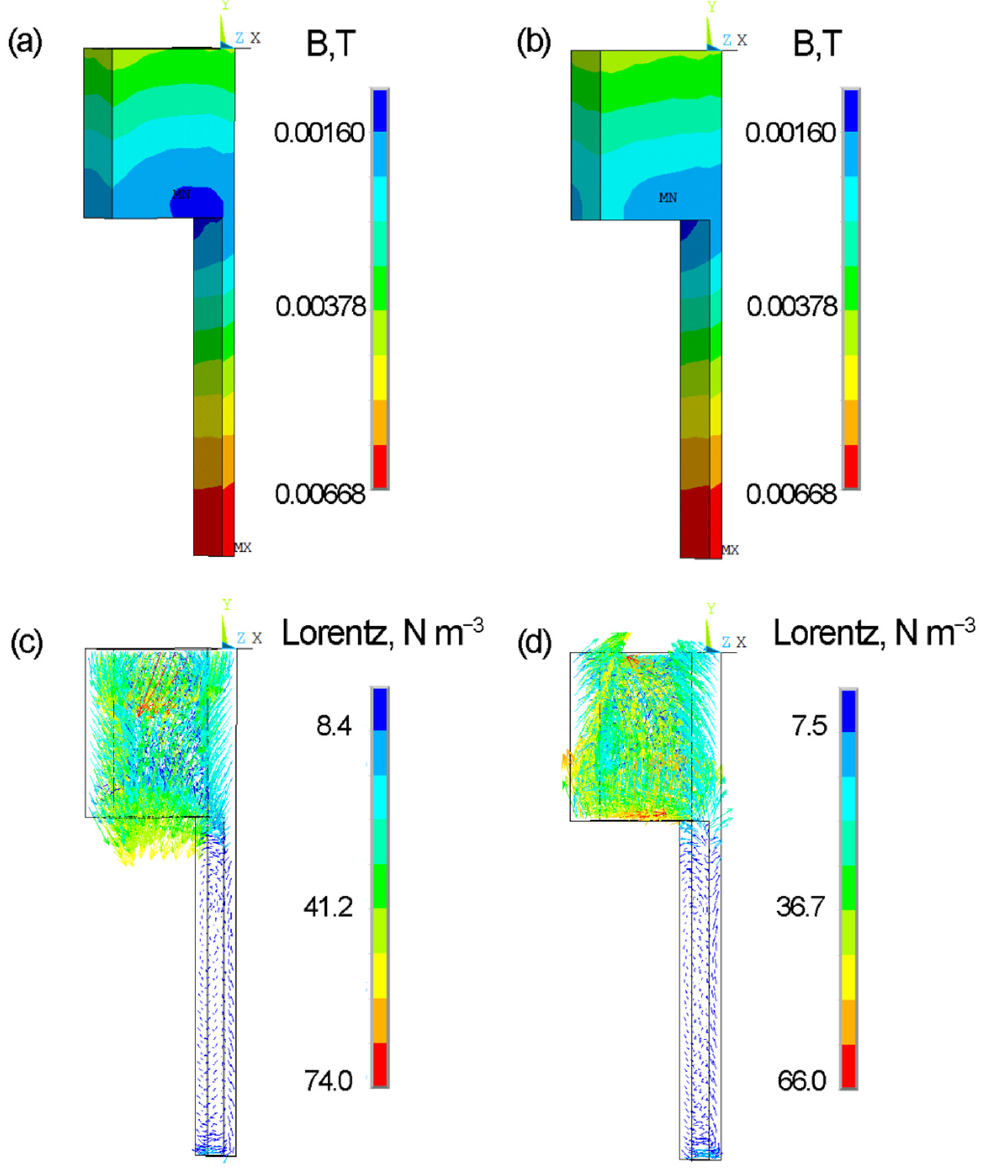
Figure 1. Numerical results computed by Ansys Emag ( I = 10 A, f = 50 Hz): ( a ) magnetic field intensity distribution, TMF down; ( b ) magnetic field intensity distribution, TMF up; ( c ) Lorentz force density distribution, TMF down; and ( d ) Lorentz force density distribution, TMF up.